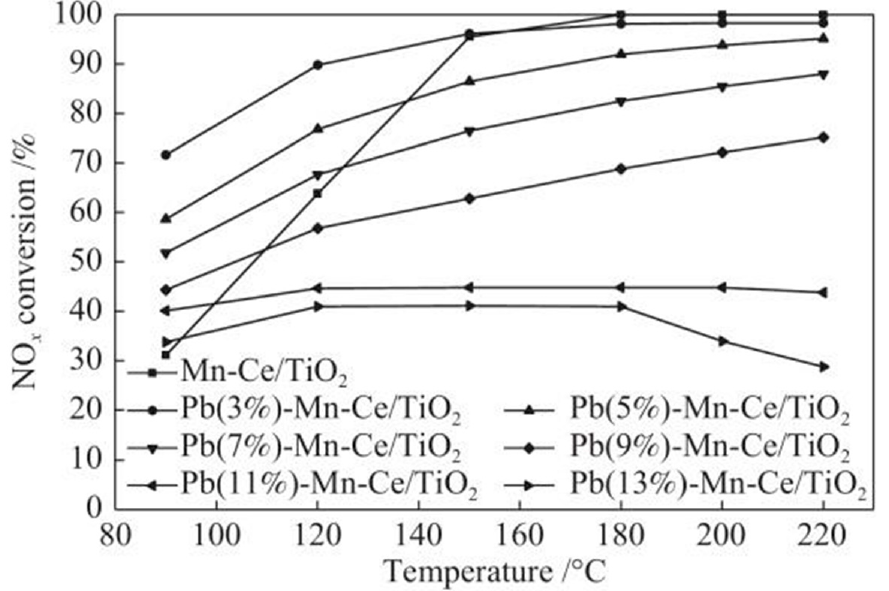
Figure 11. Activity of the Pb(x)-Mn-Ce/TiO 2 catalysts with different Pb loadings(x) in NH 3 -SCR of NO reaction conditions: ϕ NO x = 6 × 10 –4 , ϕ NH 3 = 6.6 × 10 –4 , ϕ O 2 = 3%~5%, GHSV = 8000 h –1 [65].